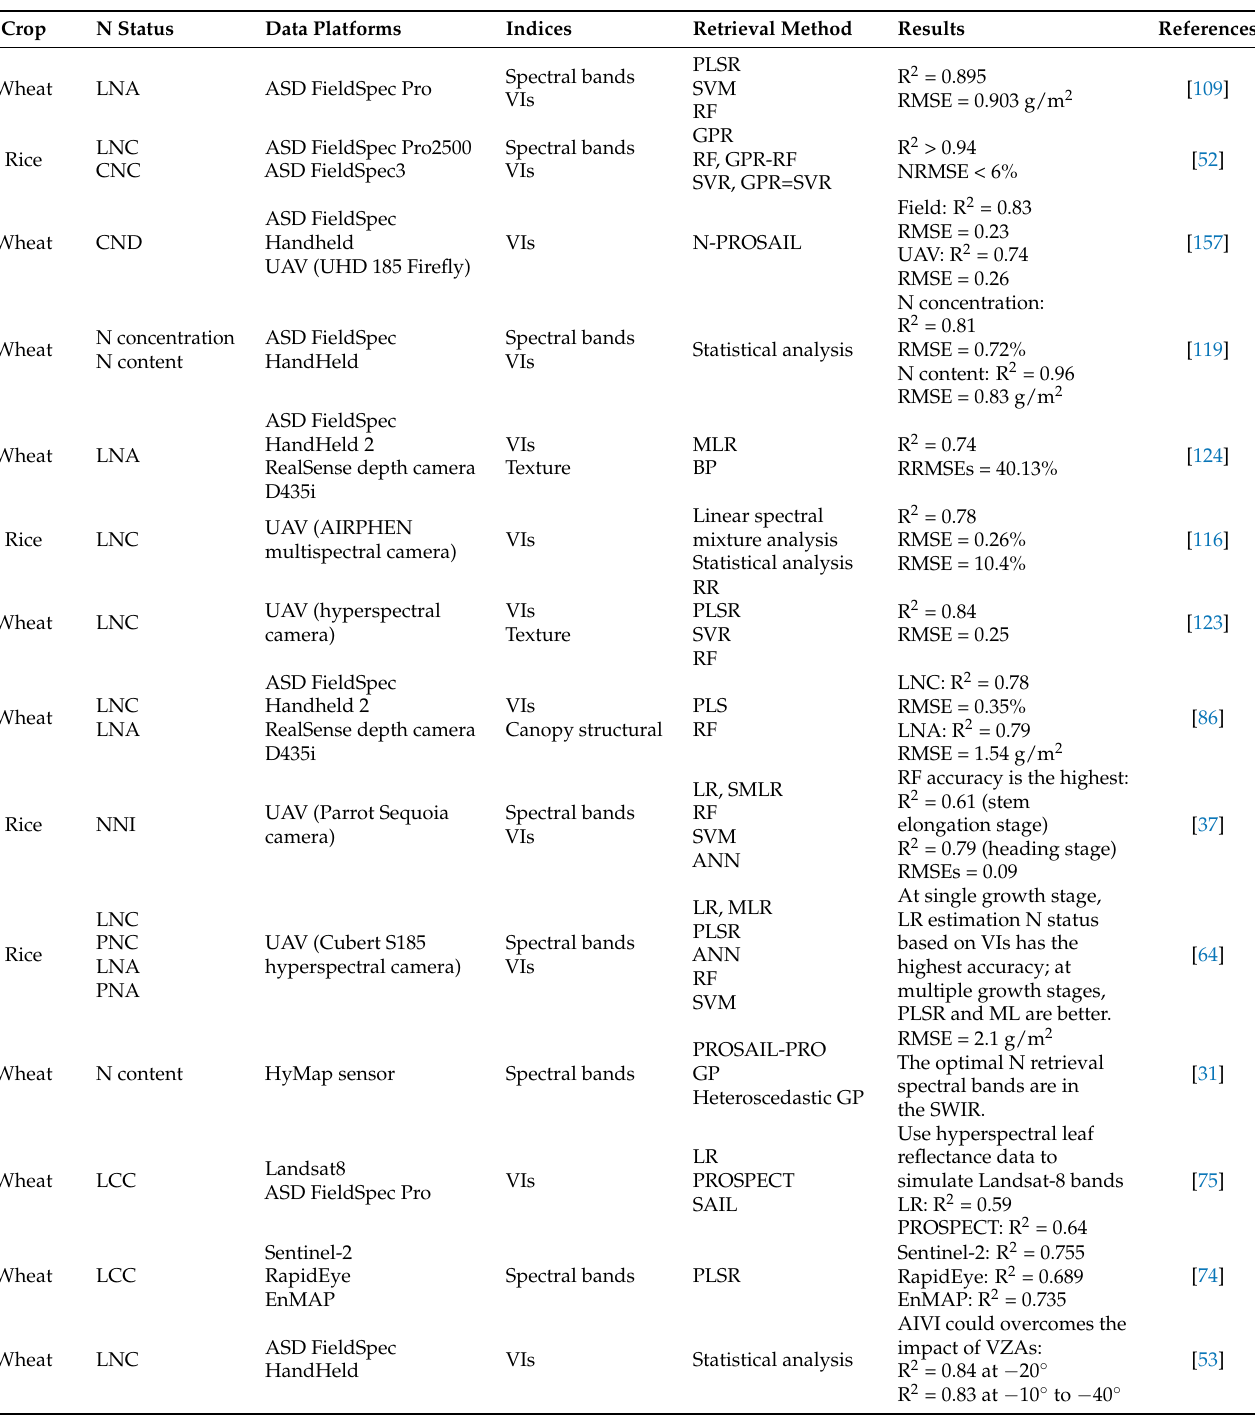
Table 2. Summary of the data platforms, retrieval methods, and research results of the studies cited in the